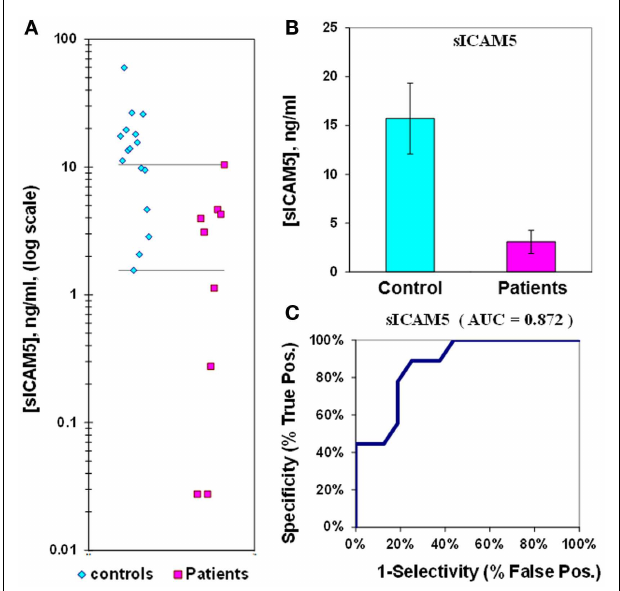
FIGURE 1 |Assay of sICAM5 in plasma from epilepsy patients and controls. (A) Dot-plot of sICAM5 concentrations in plasma (square, patients; diamond, controls). For values between the horizontal lines, the assay does not accurately discriminate between patients and controls. (B) Bar graph and error calculation for data in Part (A) . Difference is significant for p = 0.002. (C) ROC curve for data in Part a, showing an area under the curve (AUC) value of